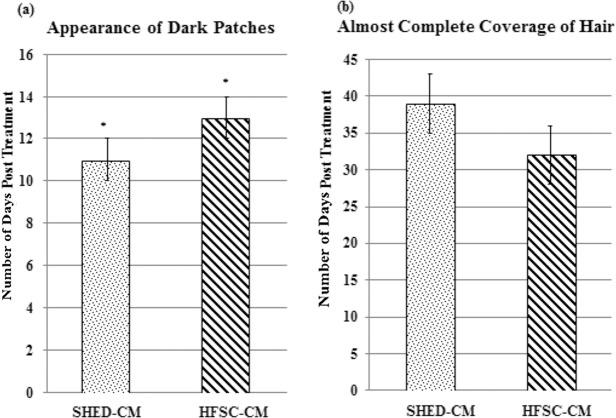
Time duration taken for the appearance of dark patches and almost complete coverage of hair upon treatment with SHED-CM and HFSC-CM.(a) The number of days taken for the appearance of dark patches in C3H/HeN mice (n = 9) when treated with three subcutaneous injections of 100 μl of SHED-CM and HFSC-CM at three day intervals (b) The number of days taken for almost complete hair coverage of the C3H/HeN mice (n = 9) when treated with three subcutaneous injections of 100μl of SHED-CM and HFSC-CM at three day intervals. * indicates a significant difference (p<0.05).